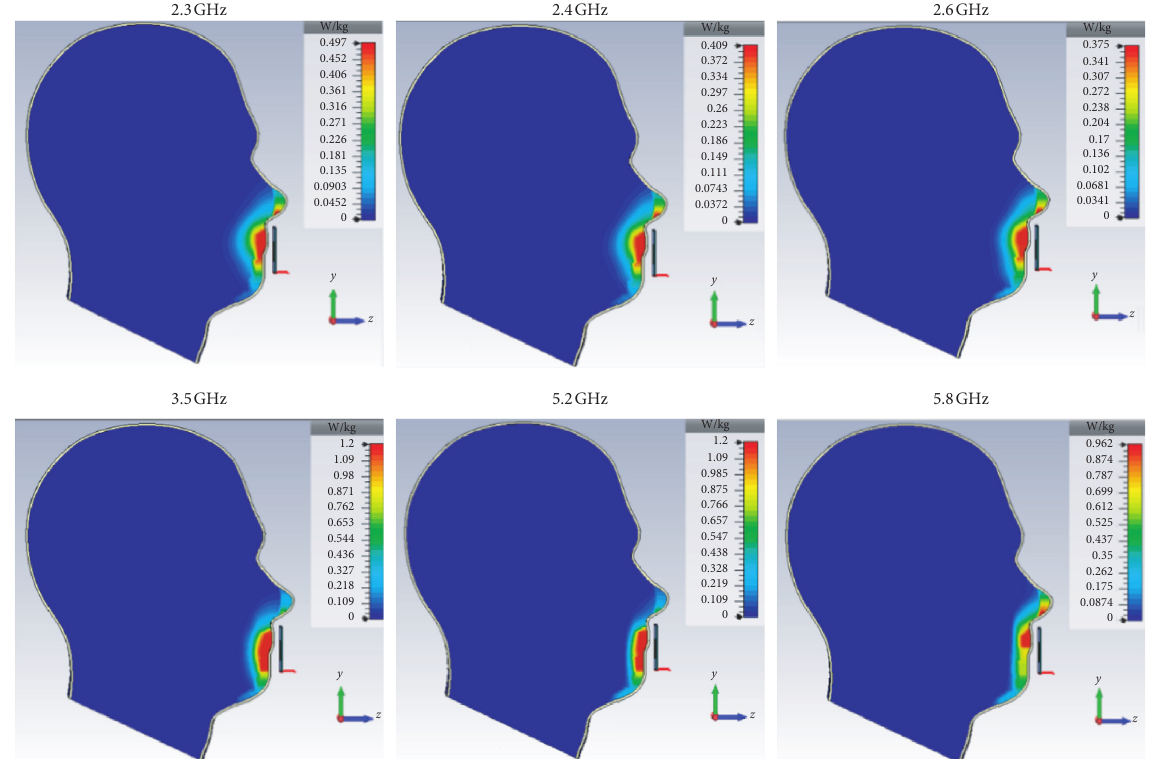
Figure 17: SAR (W/kg) distribution averaged over 10g inside SAM head, antenna 5mm separated to SAM